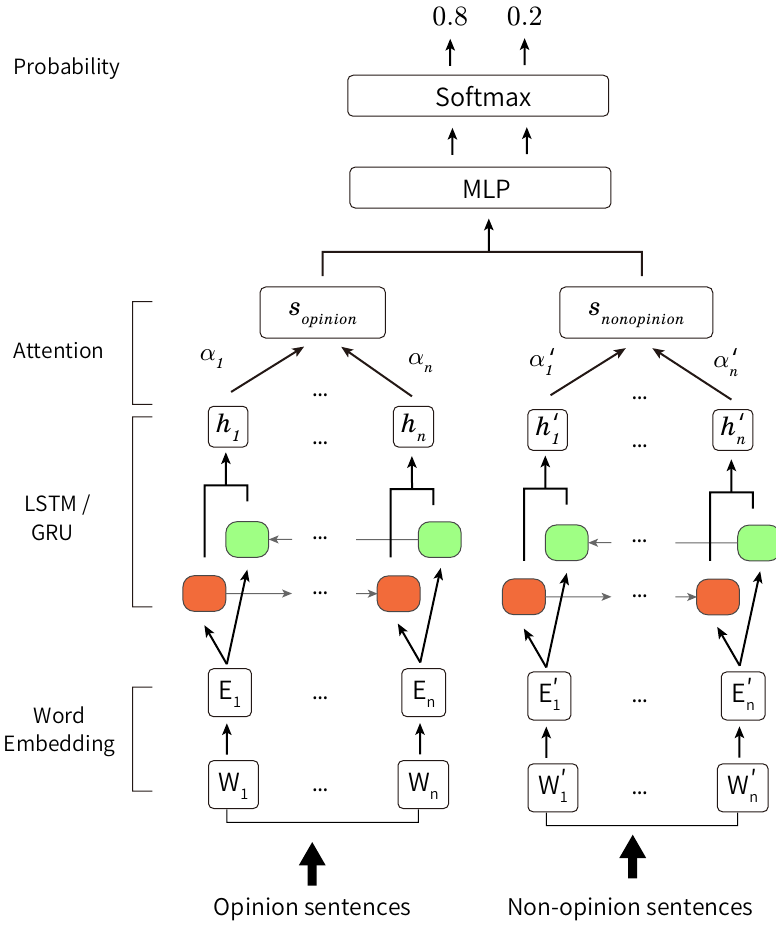
Figure 3. Overview of our method with inputs of opinion and non-opinion sentences. From the word embedding to the attention, opinion and non-opinion sentences go through separately. Then, the weighted outputs of RNNs are concatenated and input to